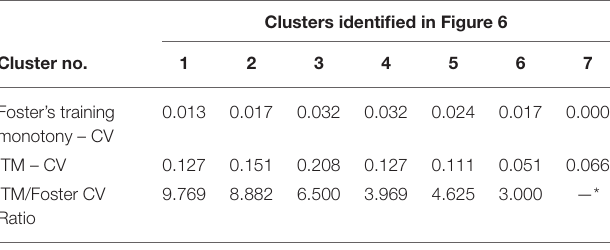
Clusters identified in Figure 6